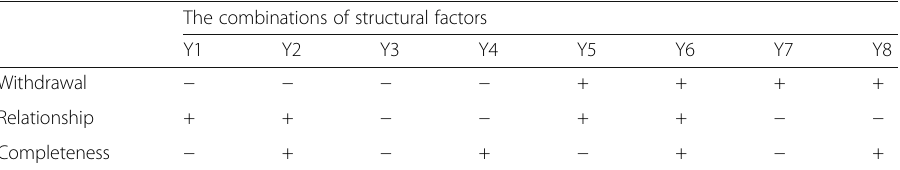
Table 2 The structural source of risk transformation The combinations of structural